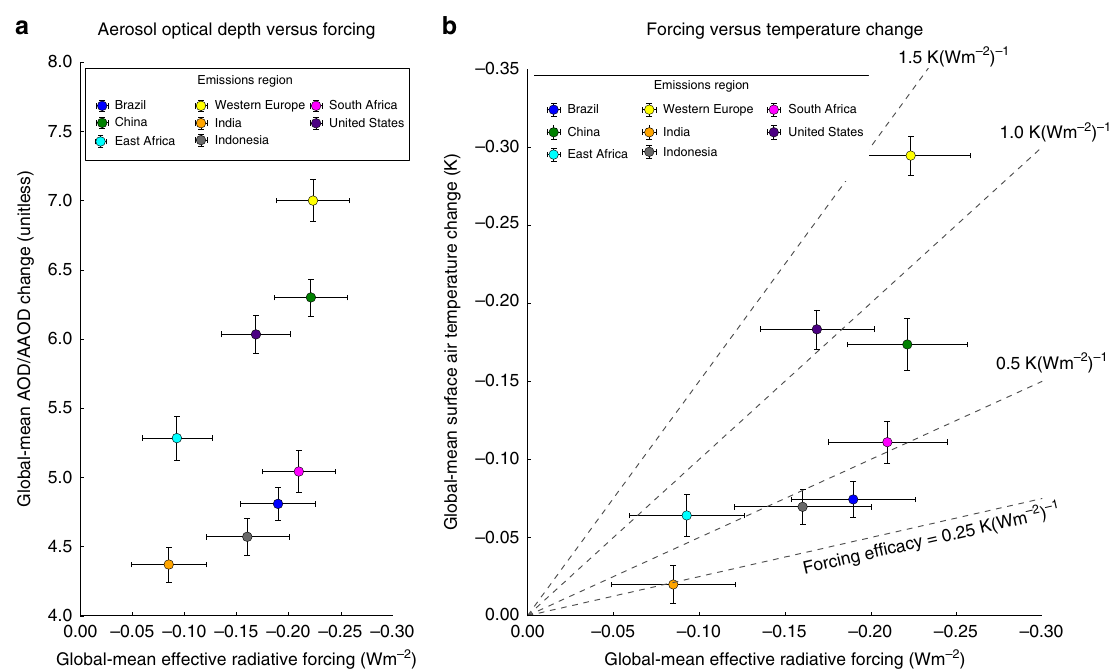
Fig. 3 Relationships between aerosol burden, radiative forcing, and temperature change. The ratio of aerosol optical depth produced by the atmospheric burden of sulfate, black carbon, and organic carbon to its absorbing component (AOD/AAOD) ( a , y -axis) explains 60% of variance in effective radiative forcing ( a , b , x -axis), which in turn has differing ef fi cacy ( b , diagonals) at producing global mean temperature changes ( b , y -axis). Error bars capture the